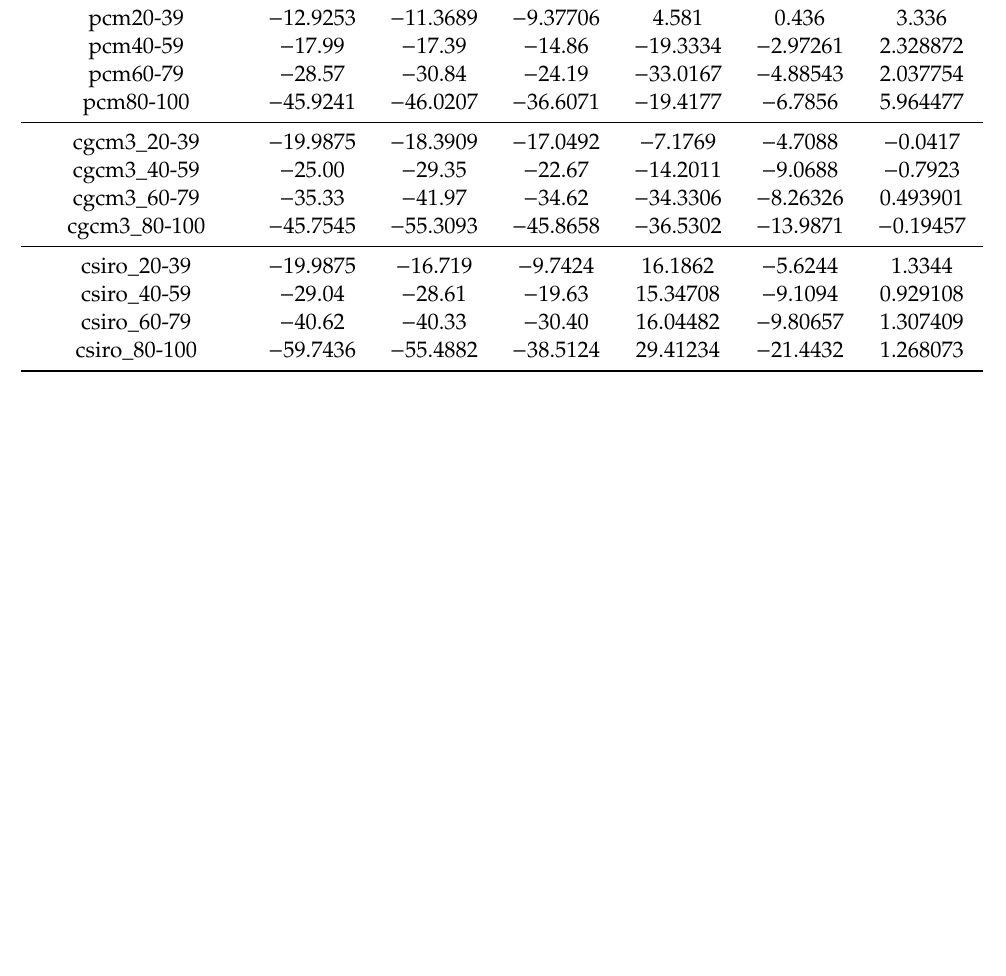
Table 4. Marginal e ff ect of temperature and precipitation on net revenue per hectare ($ ha − 1 ) . Scenario